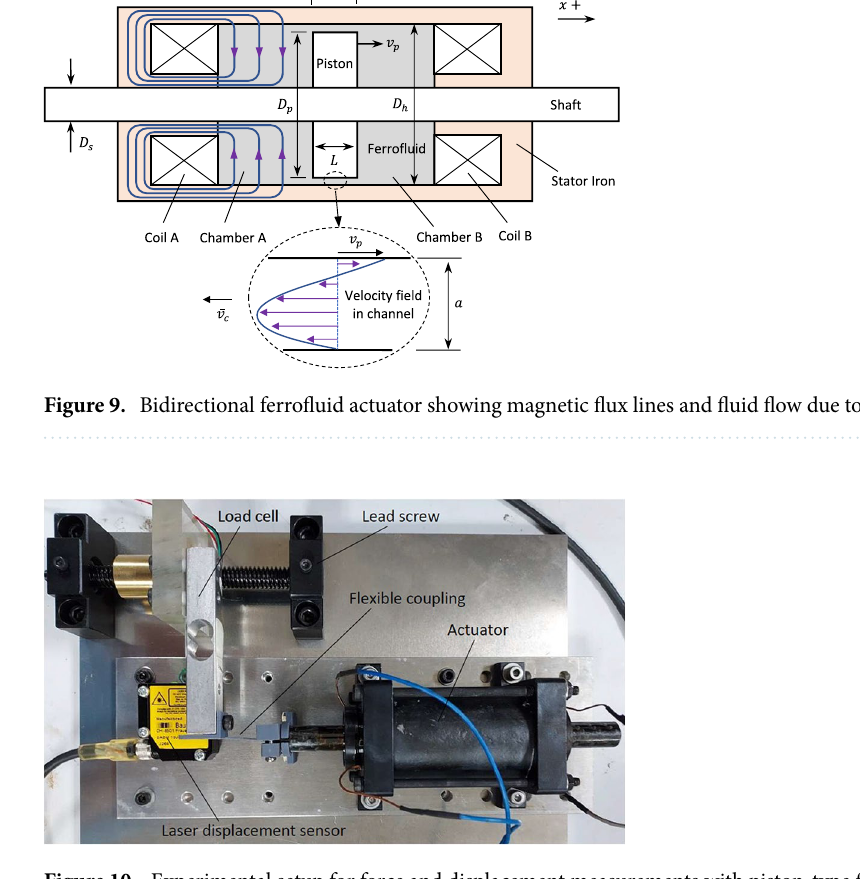
Figure 10. Experimental setup for force and displacement measurements with piston-type ferrofluid